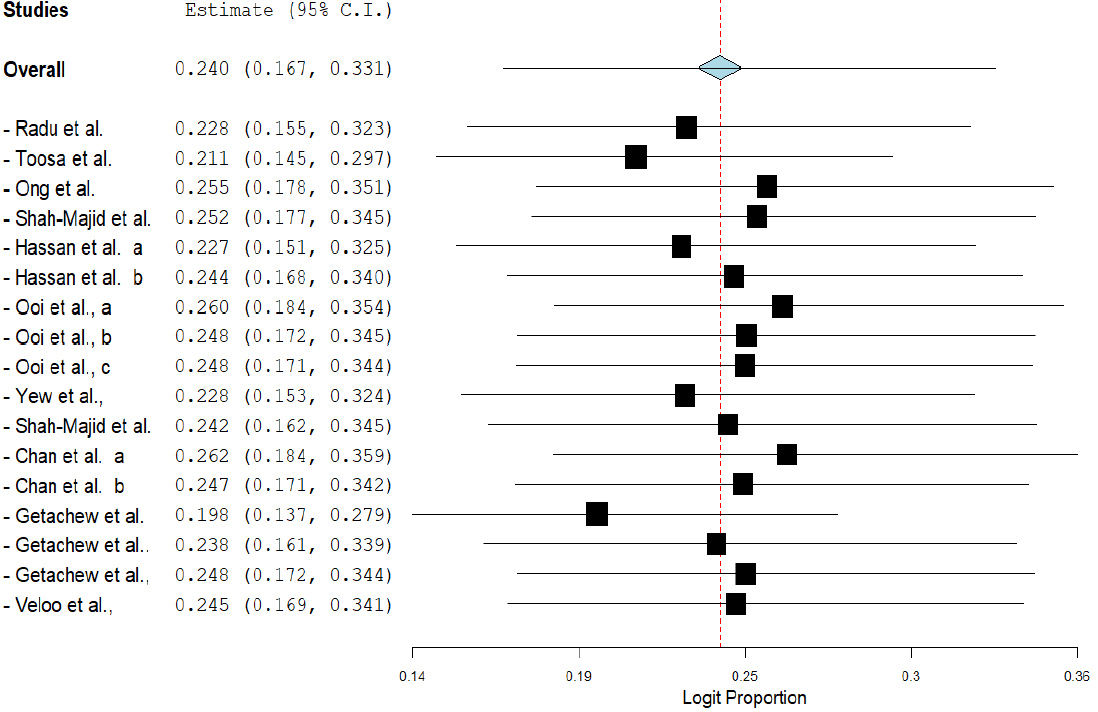
Figure 4. Funnel plot showing publication bias in studies reporting the prevalence of VRE in in poultry in Malaysia. Studies on the right side are fewer than those on the left and thus asymmetrical. The funnel plot is used for the visualization of bias. -4